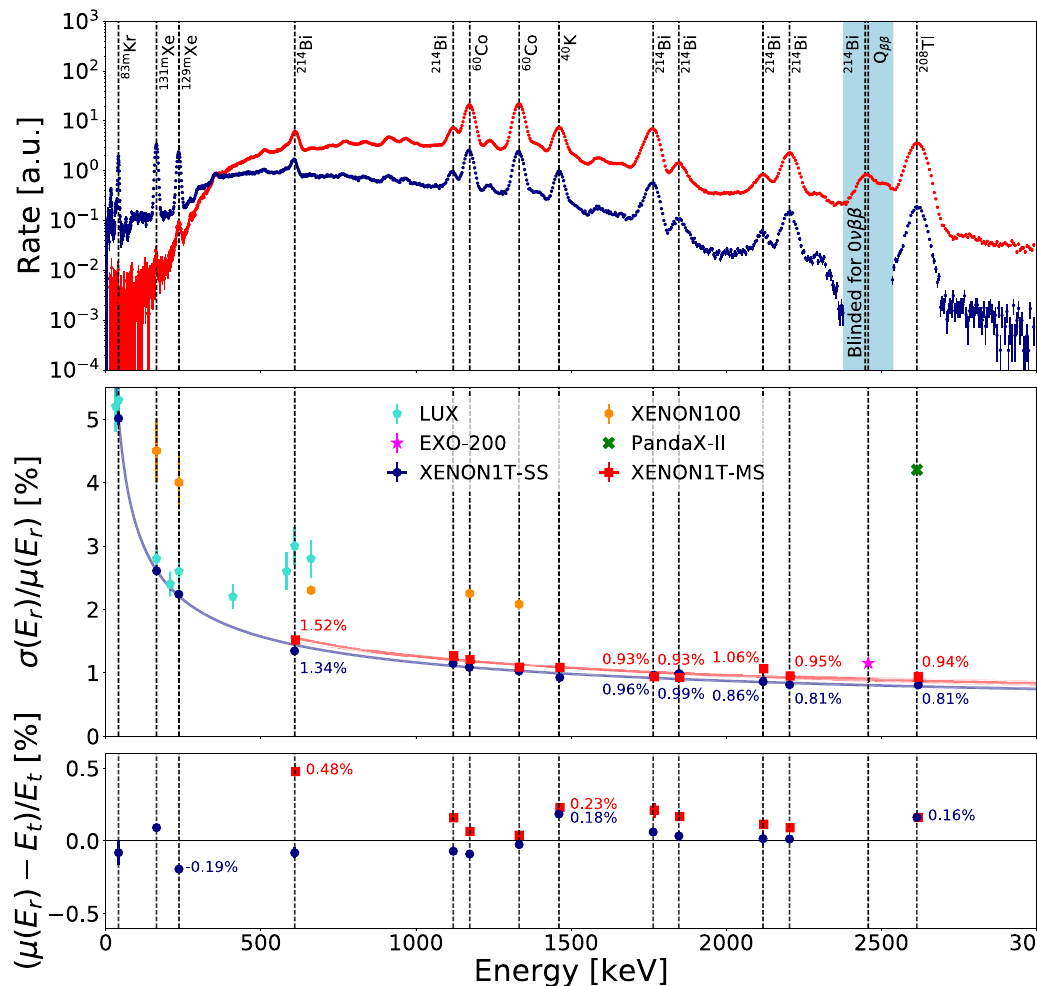
√ E + b and shown by the olutions as a function of energy are fit with a / blue and red lines, respectively, while the shaded regions cover 1 − σ statistical uncertainty of the fits. The extrapolated values for the SS are a = ( 31 . 3 ± 0 . 7 ) and b = ( 0 . 17 ± 0 . 02 ) . The resolution of